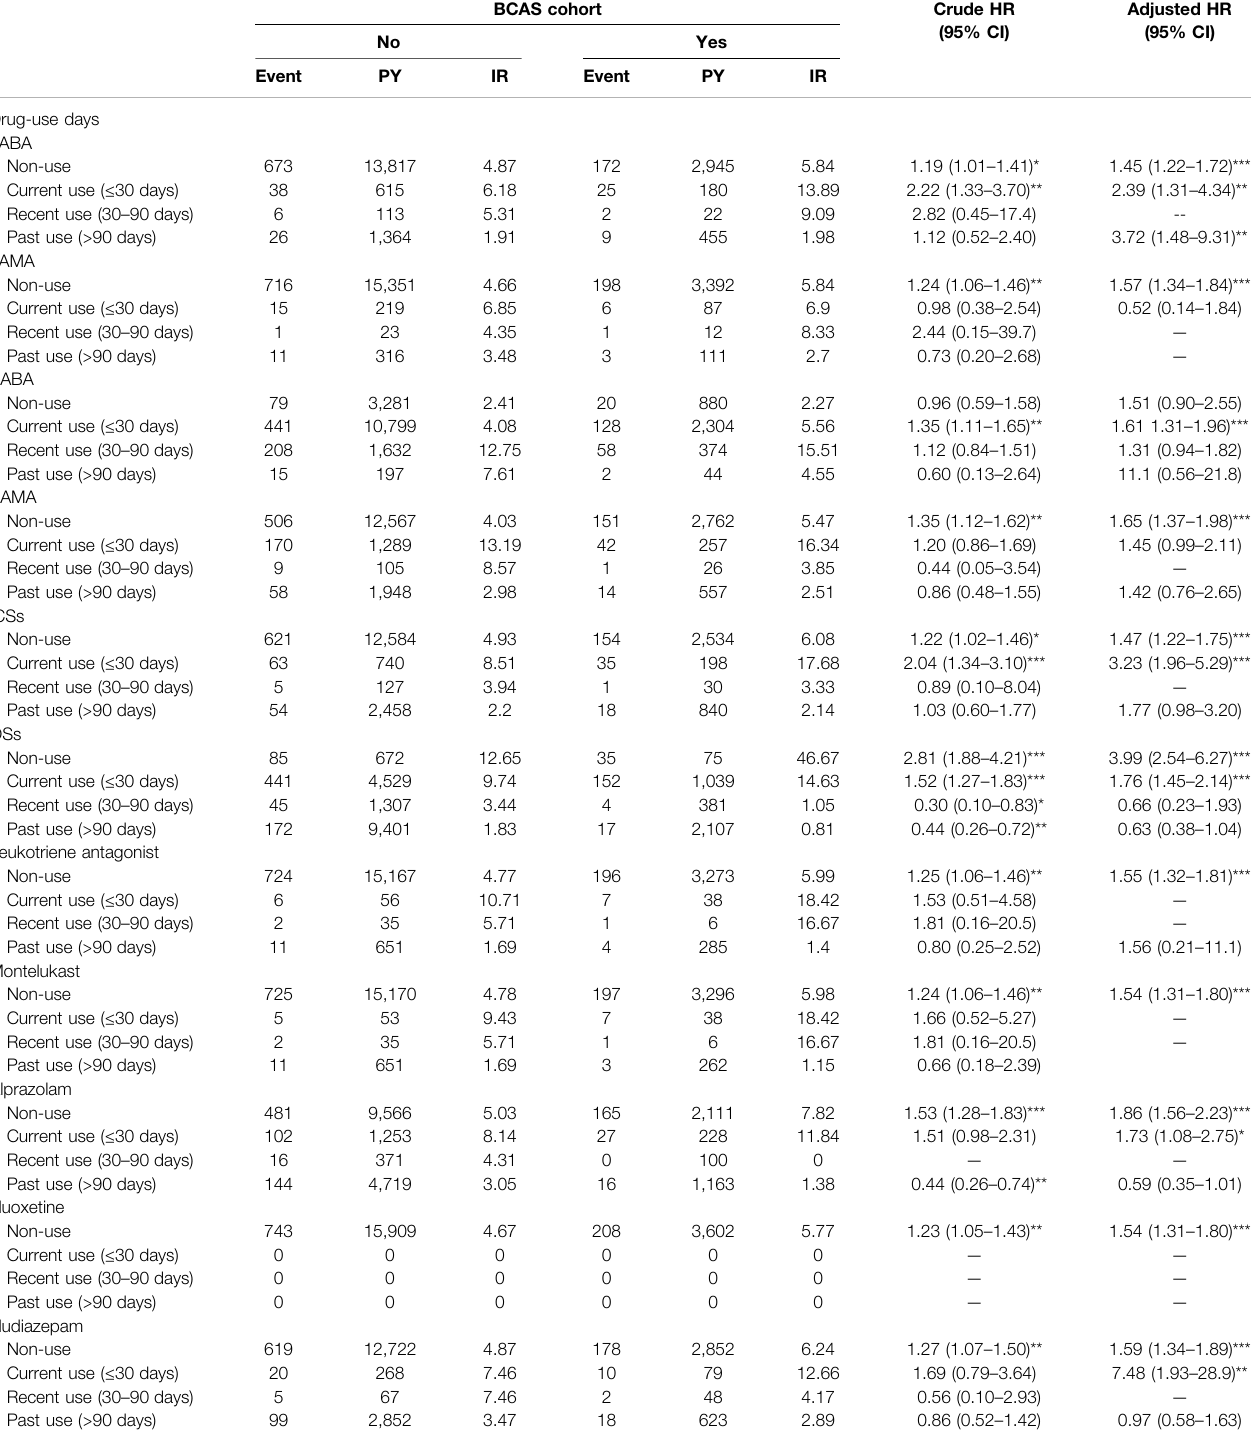
TABLE 4 | Incidence rate and hazard ratio of pulmonary tuberculosis or pneumonia between the two cohorts strati fi ed by the current, recent, and past use